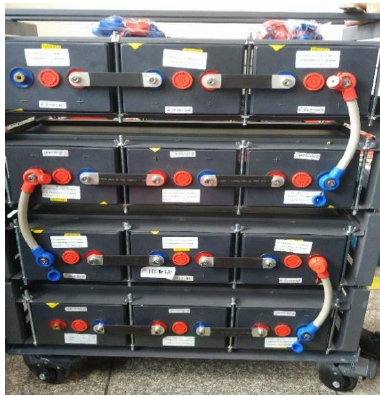
Figure 8. Twelve batteries stack.